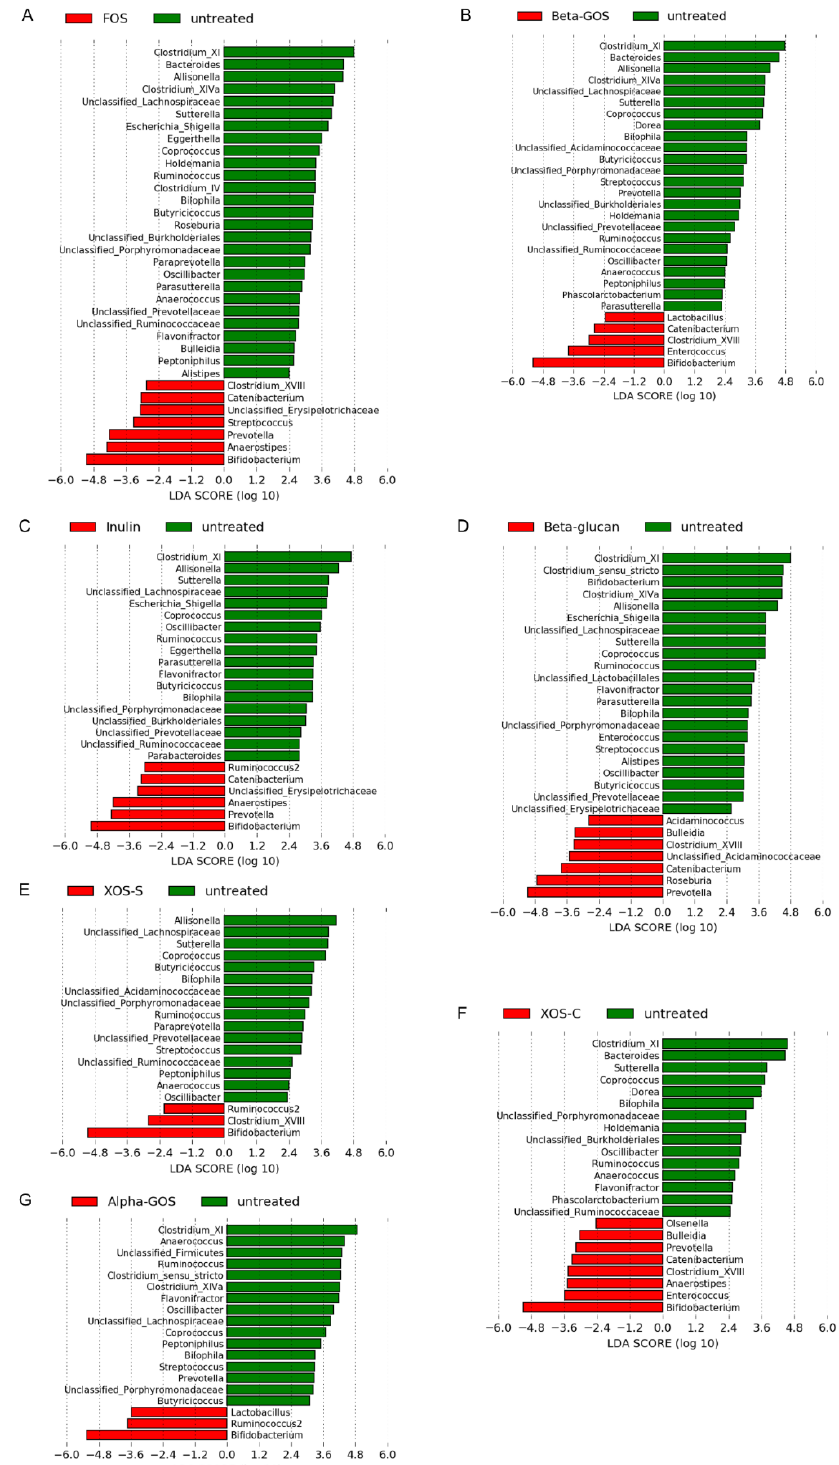
Figure 3. Identification of the most differentially abundant genera, between untreated controls and the fiber samples, using Linear Discriminant Analysis Effect Size (LEfSe) analysis. Genera enriched in the untreated samples are indicated with a positive Linear Discriminant Analysis (LDA) score (green), and genera enriched in the samples treated with different fibers are indicated with a negative LDA score (red). The threshold on the logarithmic LDA score for a discriminative genus was set to >2.0. ( A ) FOS, ( B ) Beta-GOS, ( C ) Inulin, ( D ) Beta-glucan, ( E ) XOS-S, ( F ) XOS-C, and ( G )